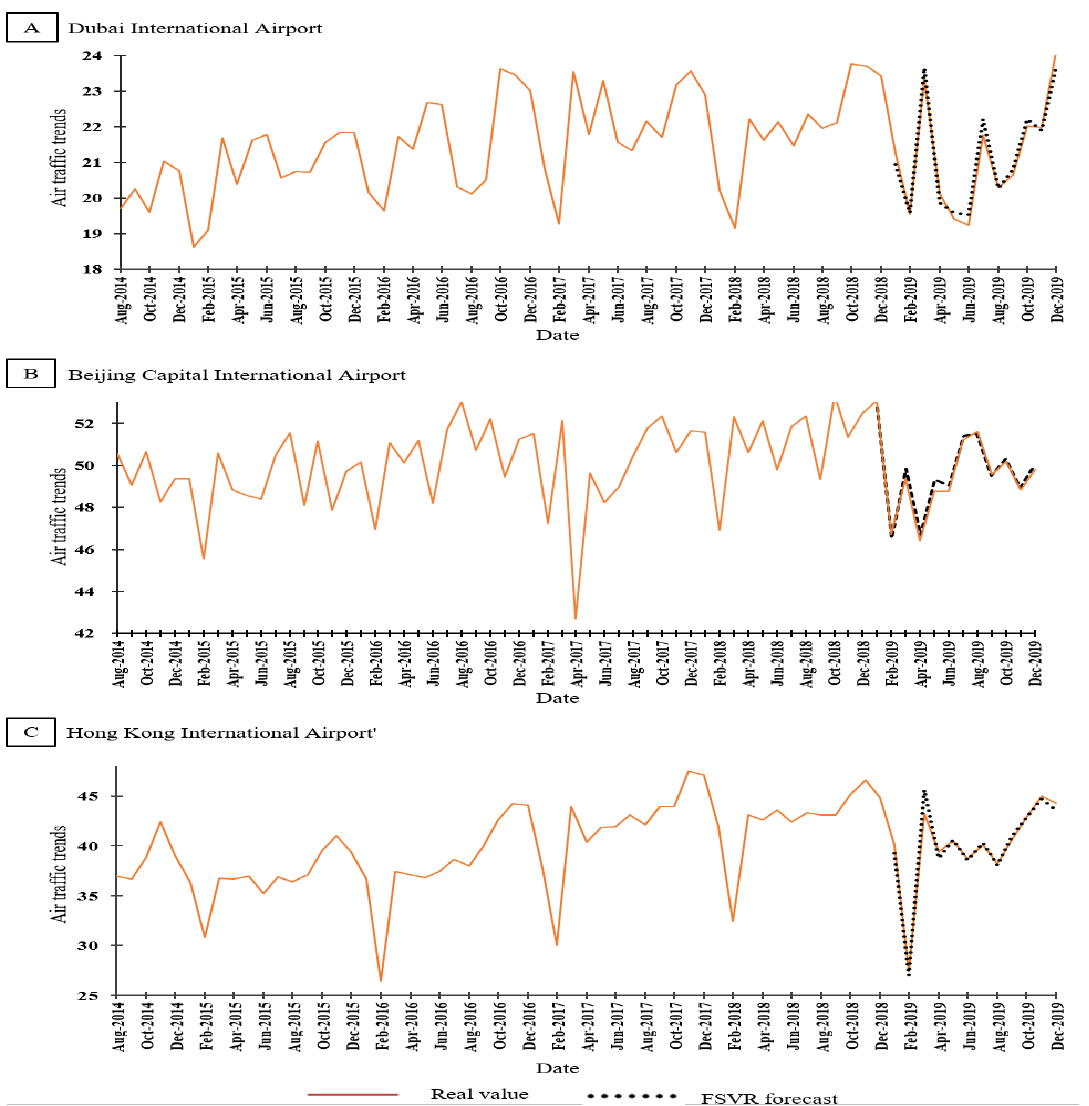
Figure 2. Comparison of air traffic trends in the past five years and FSVR forecast in 2019.